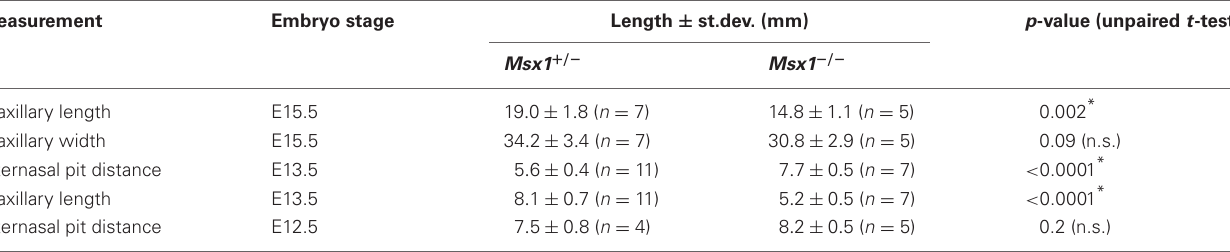
Table 1 | Histomorphometric comparison of the heads from Msx1 + / − and Msx1 − / − embryos (E12.5, E13.5, and E15.5). Measurement Embryo